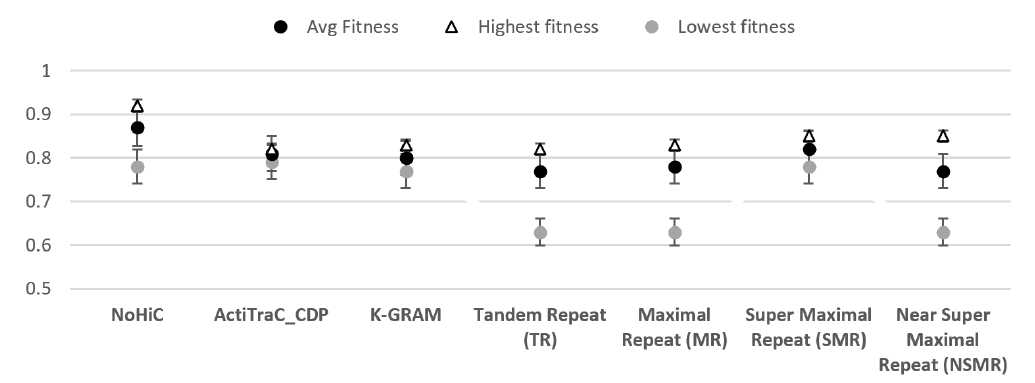
Figure 18. Comparison of lowest, average and highest fitness of the clusters generated by three trace clustering techniques.